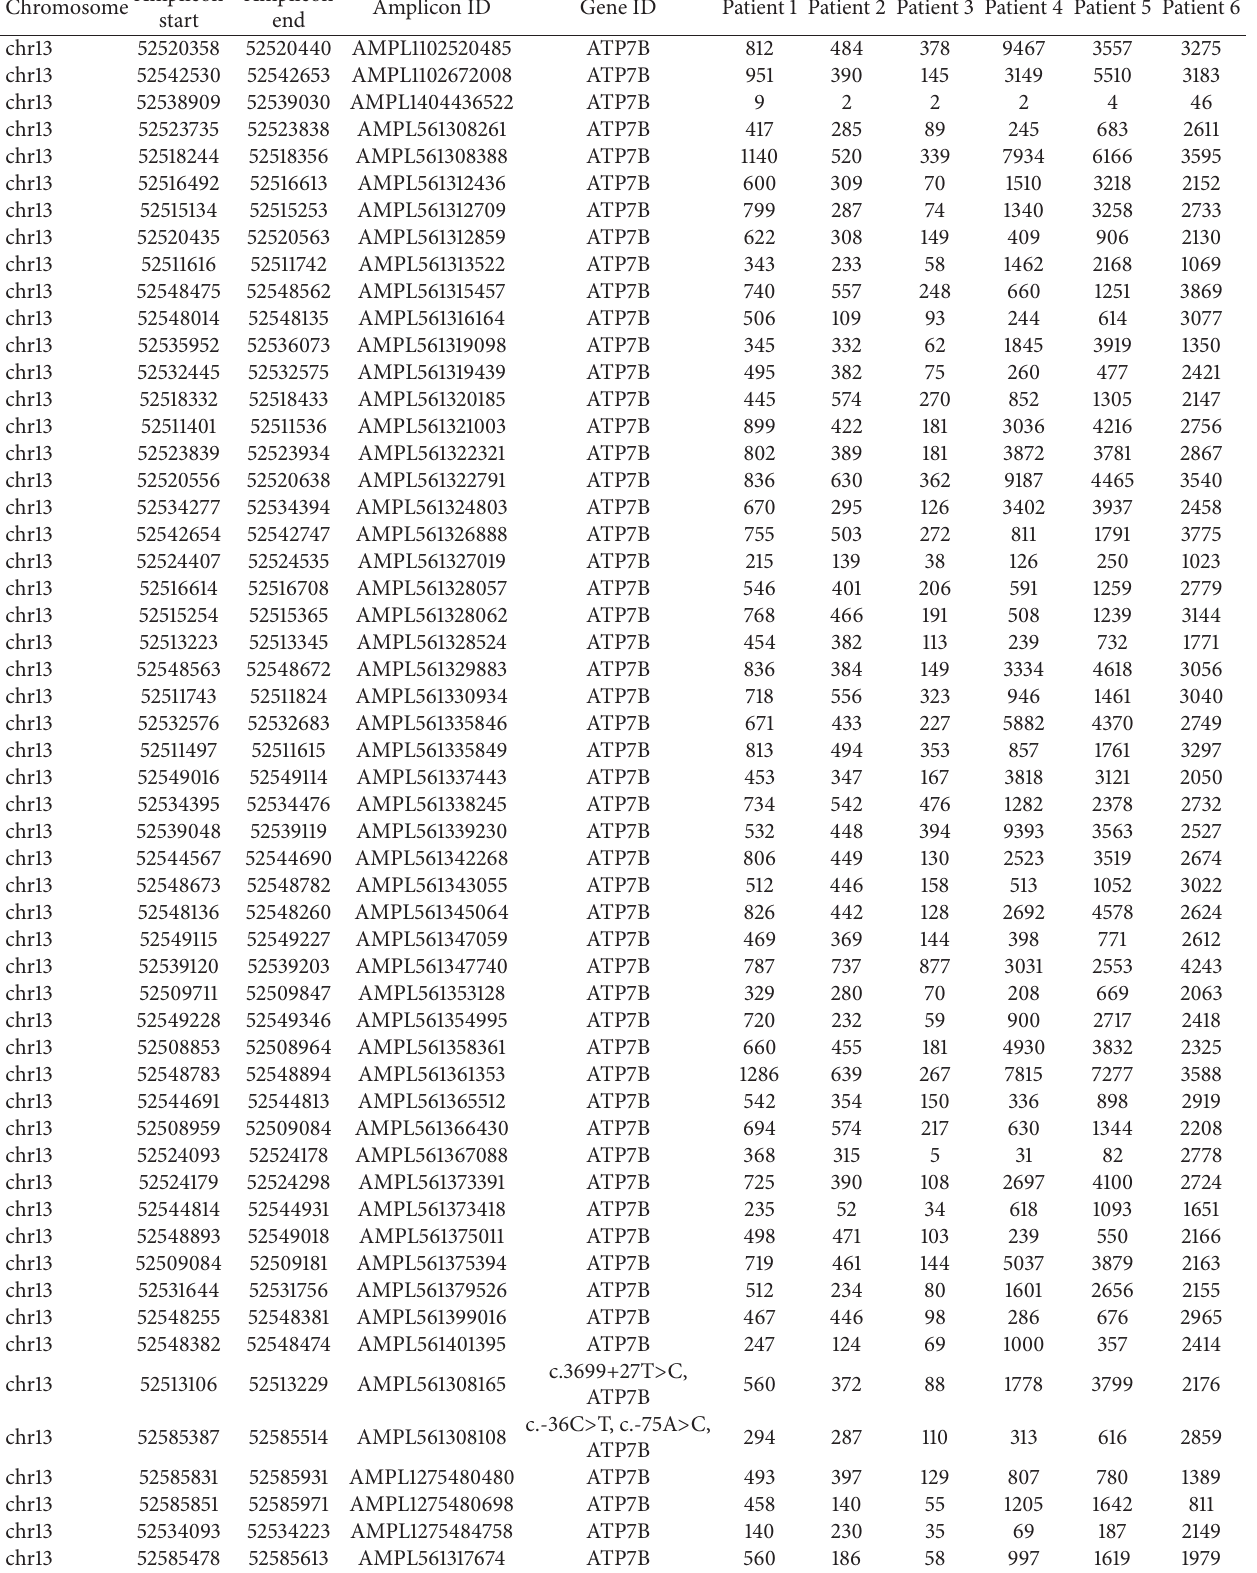
Table 2: Per sample and per amplicon coverage